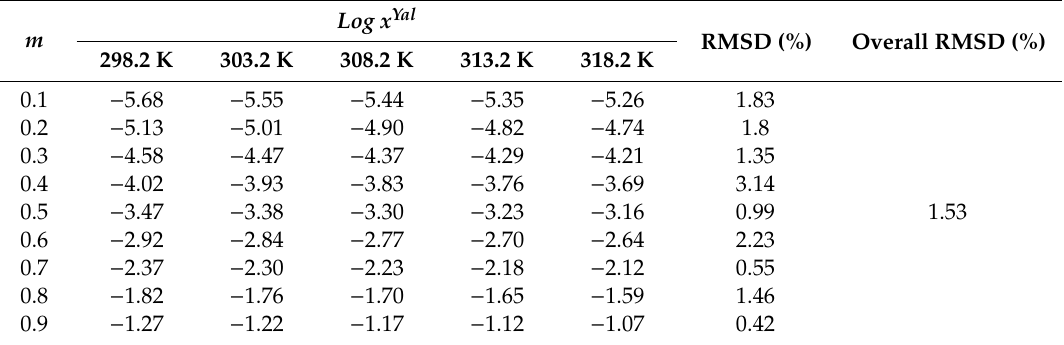
Table 7. Log x Yal values of FFA obtained by Yalkowsky–Roseman model in various Carbitol + water combinations ( m ) at T = 298.2–318.2 K.